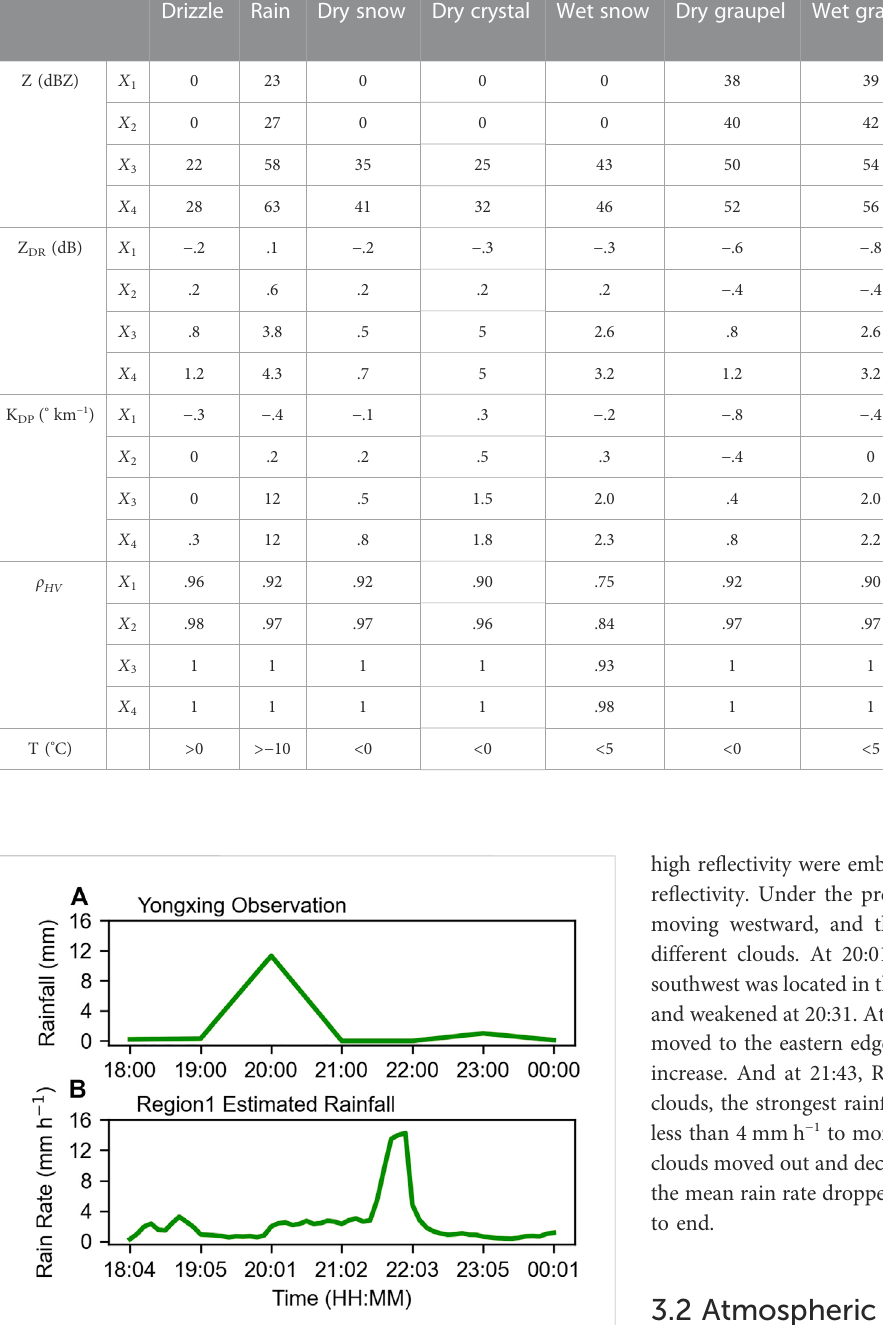
TABLE 1 Parameters of the membership functions for 10 hydrometeor types. Drizzle